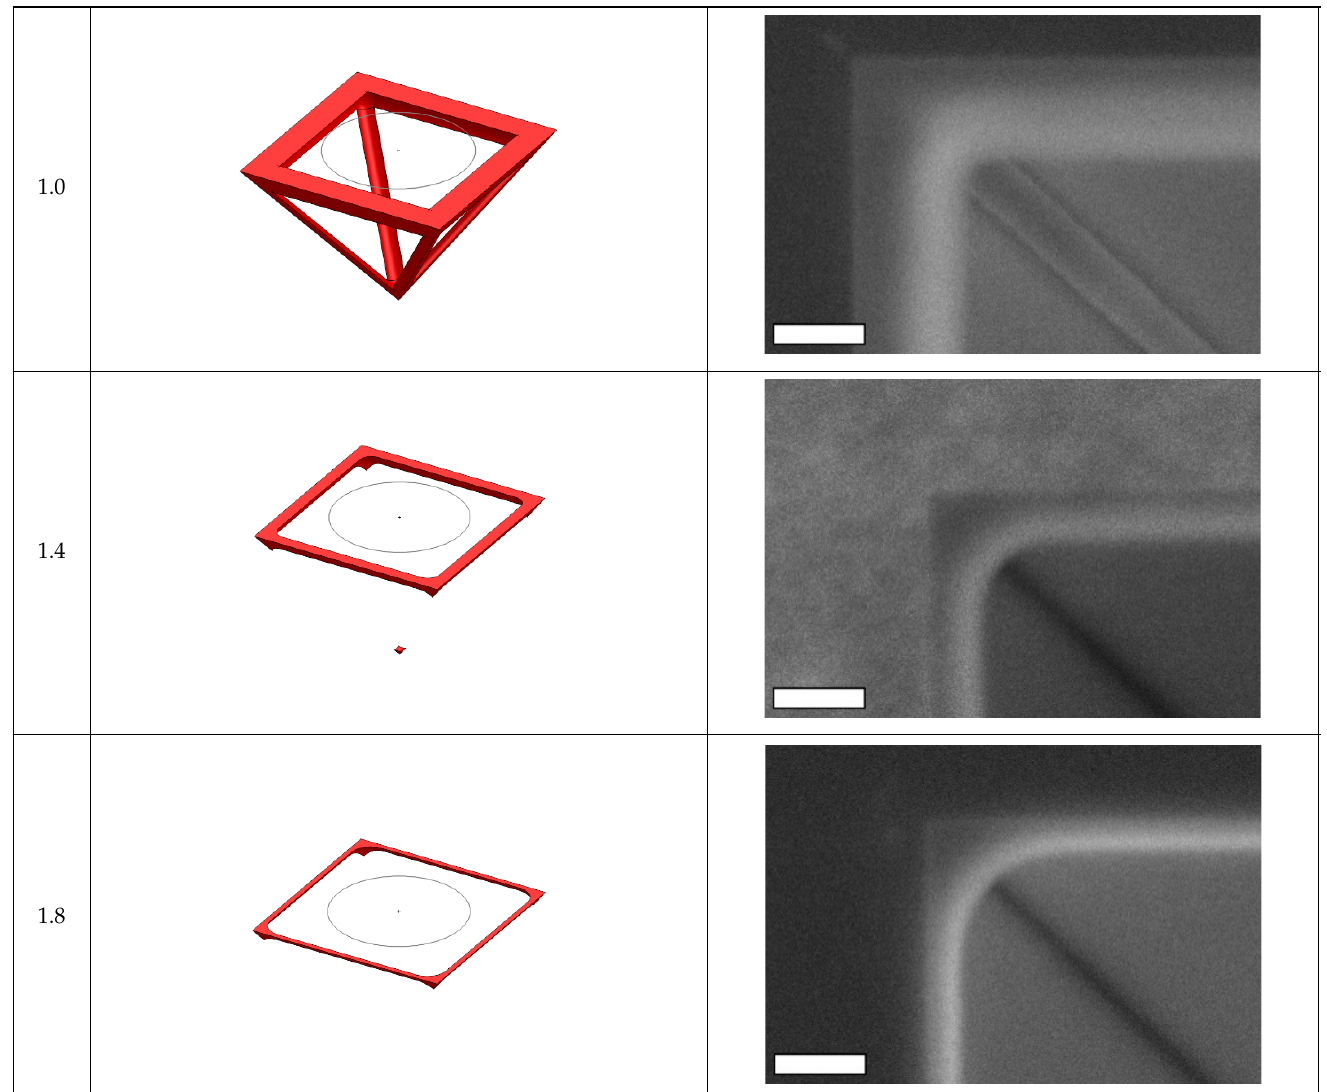
Table 3. Left: the etch factor (EF). Middle: sketch of the Si 3 N 4 frame under the SiO 2 hard-mask in the Si. Right: top-view SEM images taken from a single corner of the inverted pyramid. The scale-bars are 200 nm.